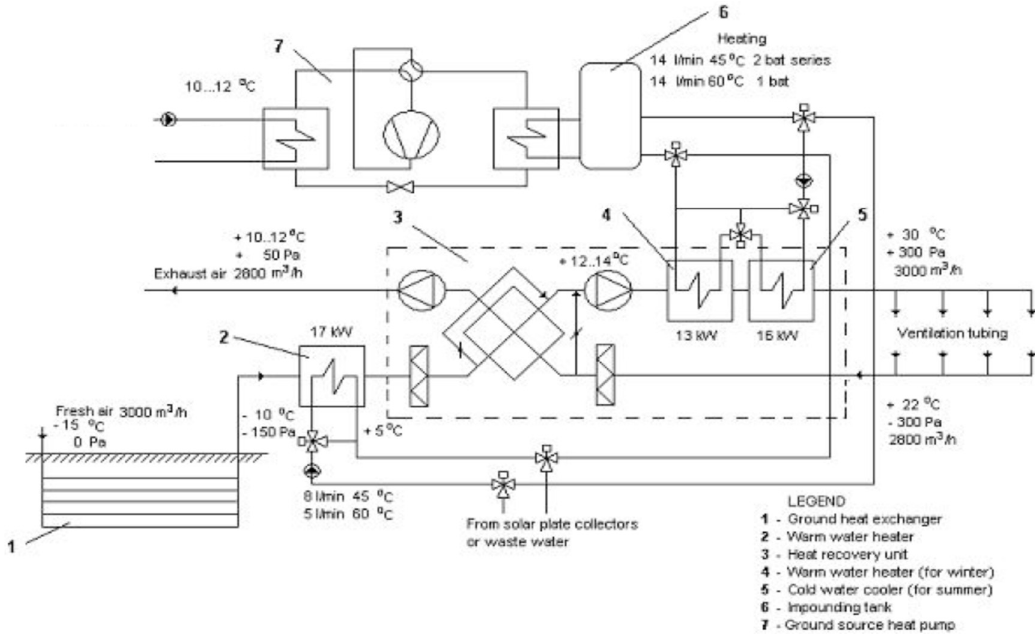
Fig. 6. The building ’ s HVAC